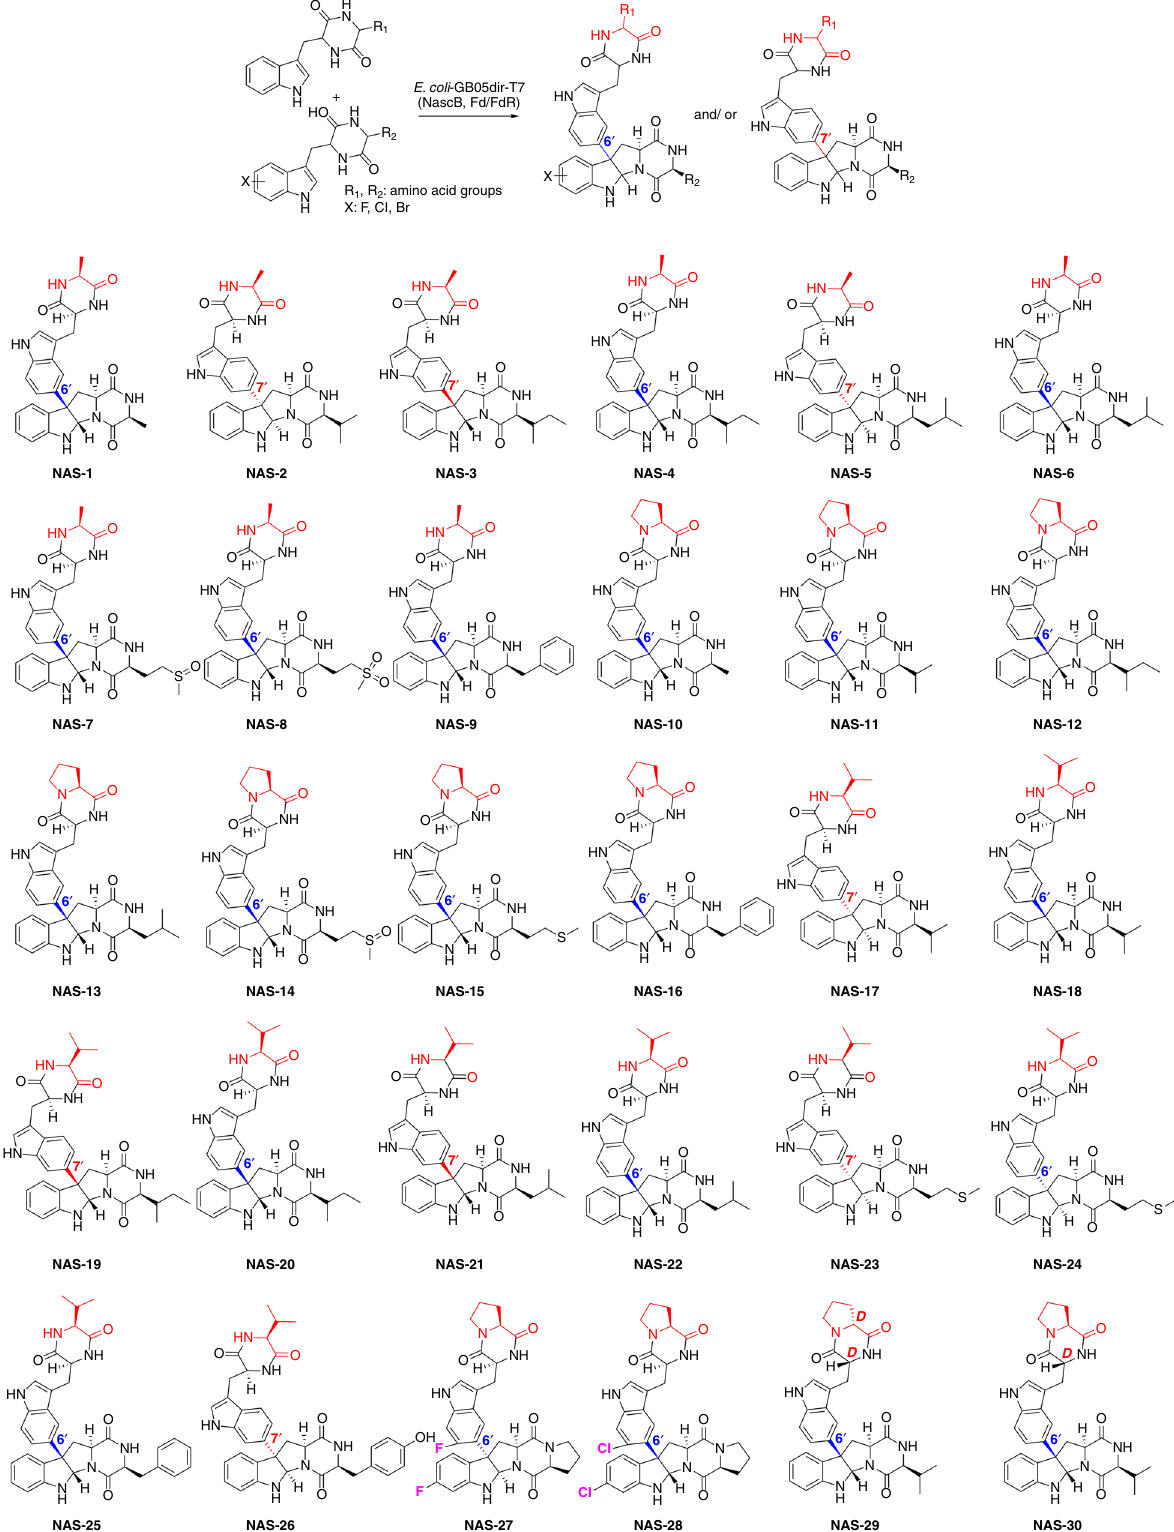
Fig. 4 Products generated by the catalysis of the whole-cell system. The non-tryptophan residues in the upper moiety are highlighted in red. Connections between the upper moiety and lower pyrroloindoline moiety are indicated by two different colors: blue color for C 3 – C 6 ′ bond, while red color for C 3 – C 7 ′